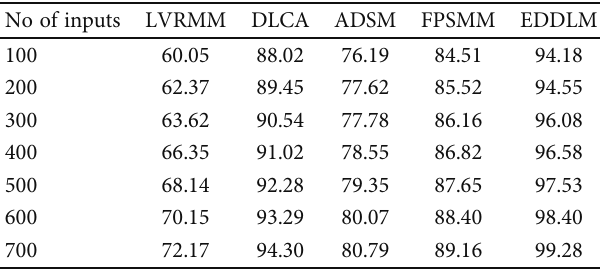
Table 8: Energy e ffi ciency